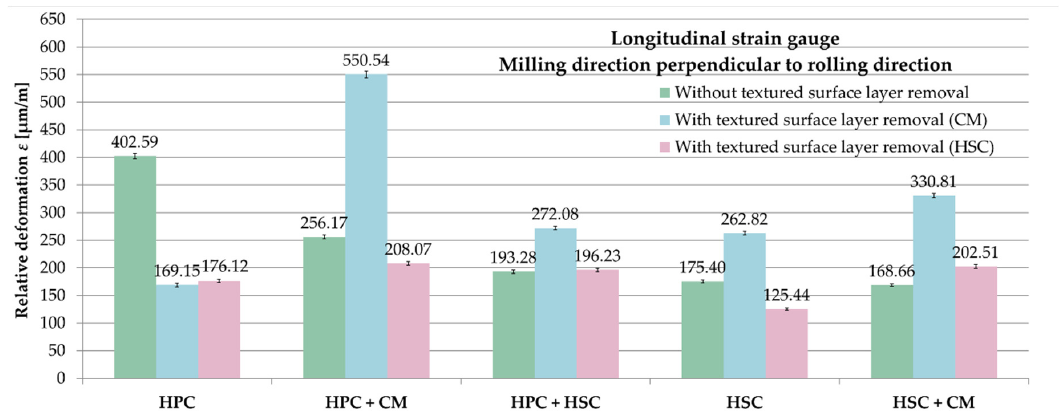
Figure 12. Comparison of relative deformations ε from longitudinal strain gauges depending on the applied pre-machining–milling direction perpendicular to rolling direction.